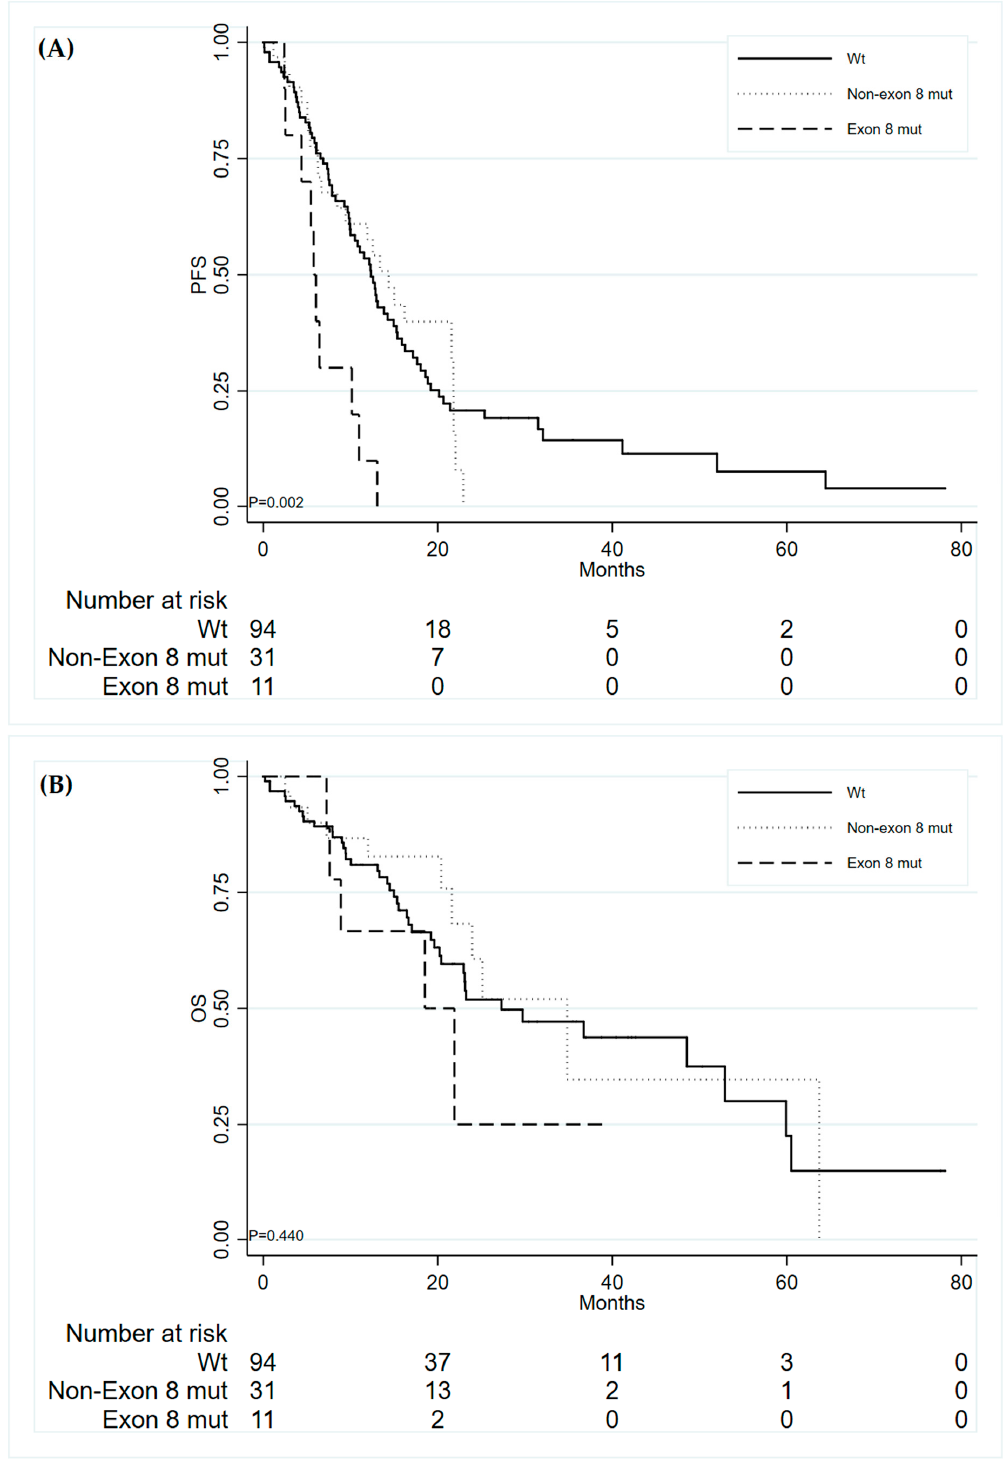
Figure 1. Progression-free survival ( A ) and Overall Survival ( B ) of patients according to